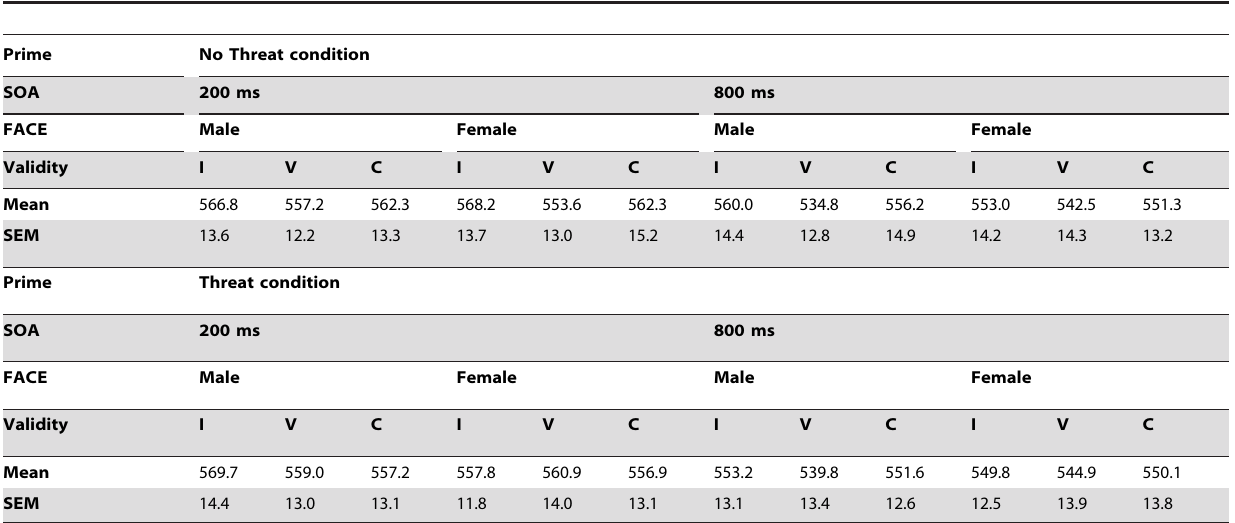
Table 2. Mean reaction time (in ms) and standard error of the mean for target discrimination in each of the different conditions.